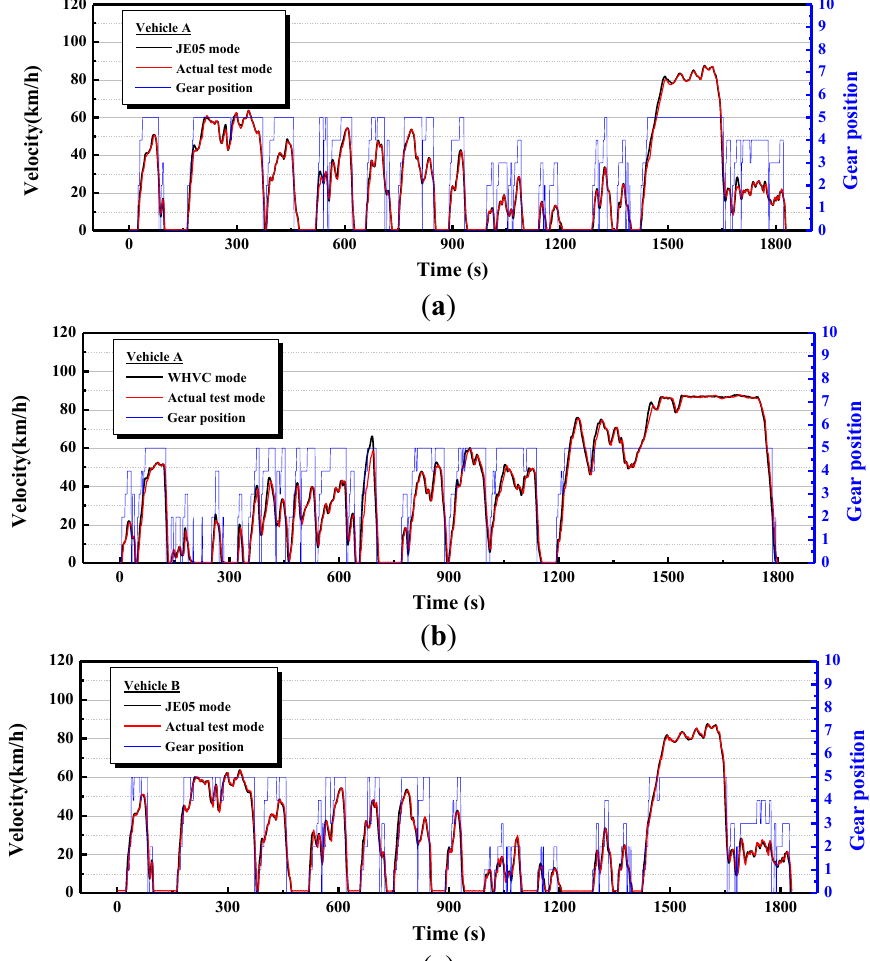
Figure 7. Comparison of vehicle profiles between approved driving mode and actual test driving mode and predicted gear position according to time: ( a ) Vehicle A, JE05 mode; ( b ) Vehicle A, WHVC mode; ( c ) Vehicle B, JE05